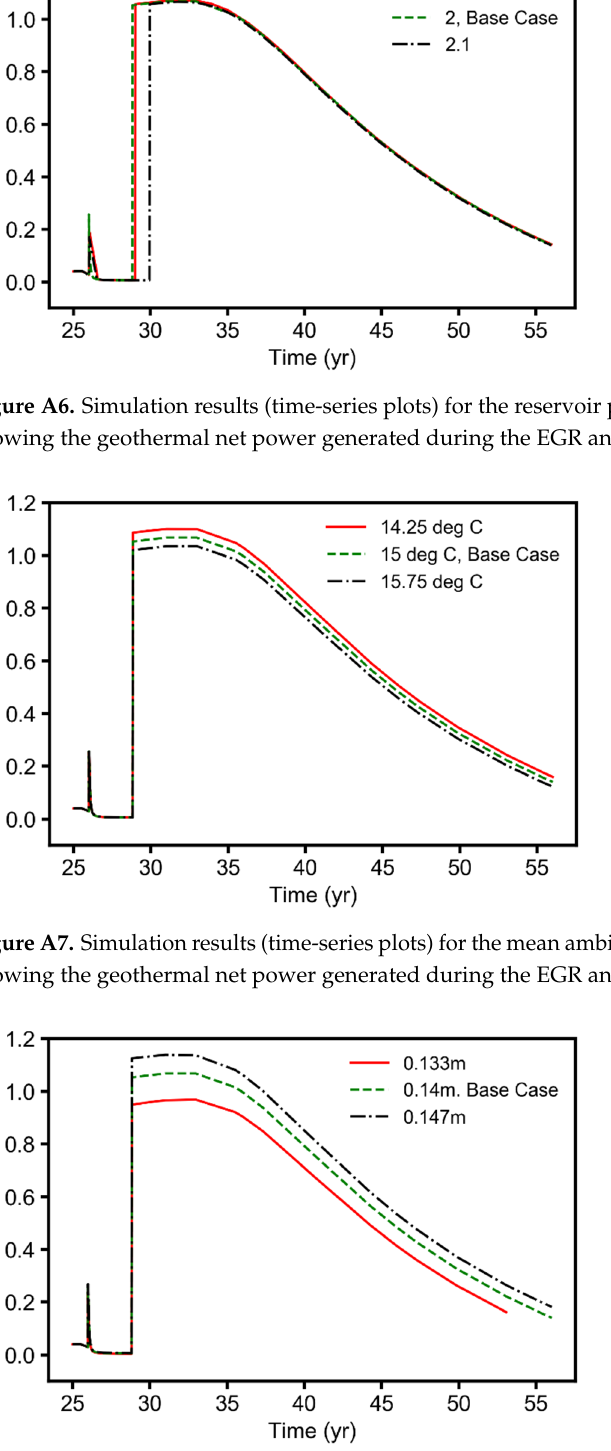
Figure A8. Simulation results (time-series plots) for the well pipe diameter, showing the geothermal net power generated during the EGR and CPG stages (25–55 years).